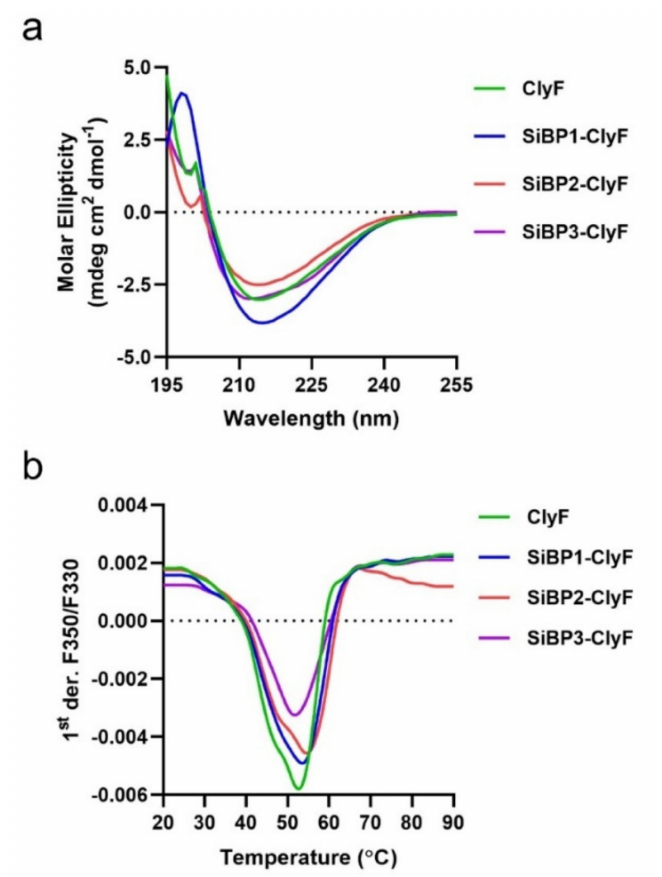
Figure 2. Biochemical properties of ClyF and its variants. ( a ) Circular dichroism spectra of ClyF and its variants. The UV spectra of ClyF and its variants were scanned from 190–260 nm (0.1 cm path length) at room temperature. ( b ) Thermal unfolding profiles for ClyF and its variants. The profiles of all proteins were determined by nanoDSF from 25–90 ◦ C. The Y -axis represents the first derivative of the ratio of fluorescence at 350 nm and 330